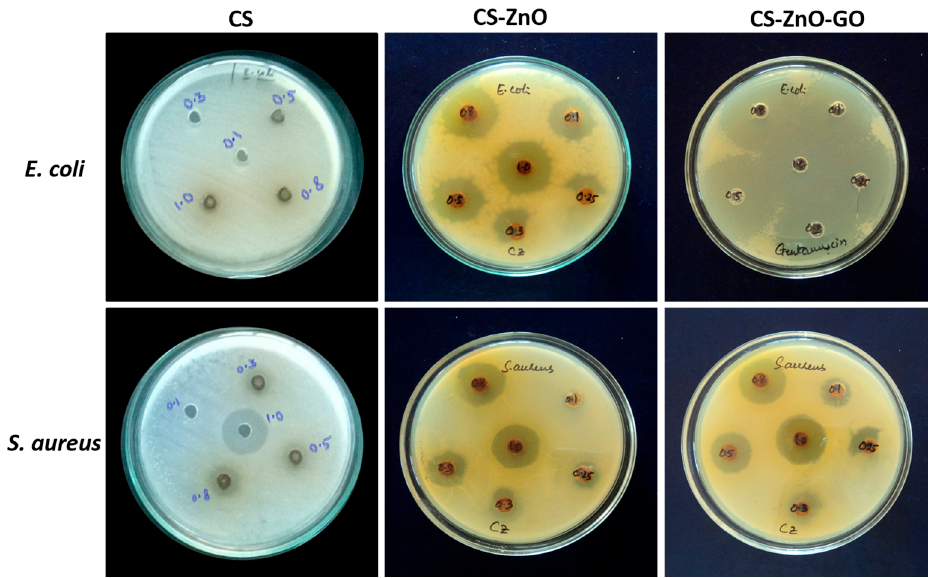
Figure 8. Antibacterial studies with CS and the CS–ZnO and CS–ZnO–GO hybrids against E. coli and S. aureus. The samples were incubated at 35 °C for 24 h. Table 1. Minimum inhibitory concentration (MIC) values of chitosan (CS) and its hybrids against E. coli and S. aureus.